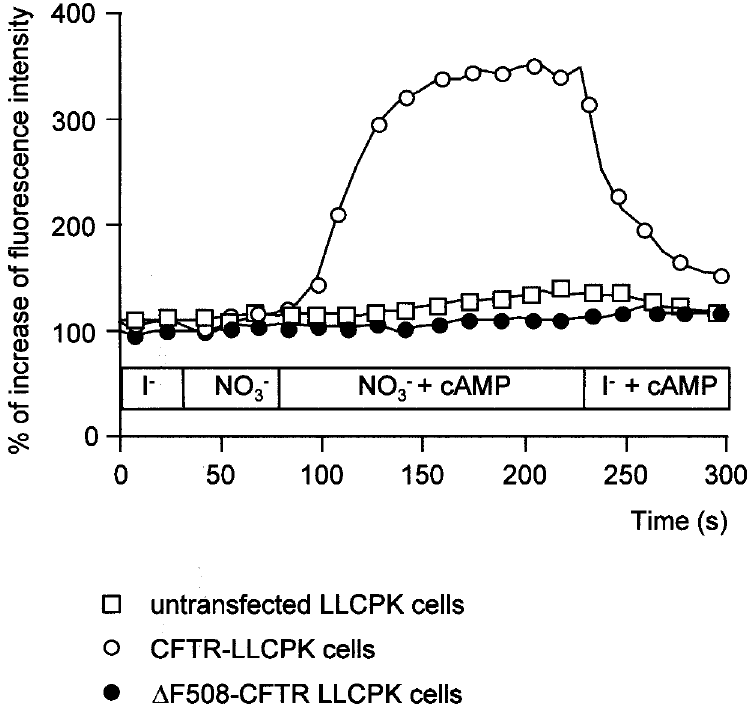
FIG. 2. Validation of the MEQ technology. The fluorescence of intracellular MEQ was registered in untransfected LLCPK cells ( h ) and in LLCPK cells expressing either the wild type CFTR ( s ) or the D F 508 -CFTR ( d ), under sequential anionic substitutions of the superfusing medium and addition of permeant cpt-cAMP, as indicated in the inset and described in materials and